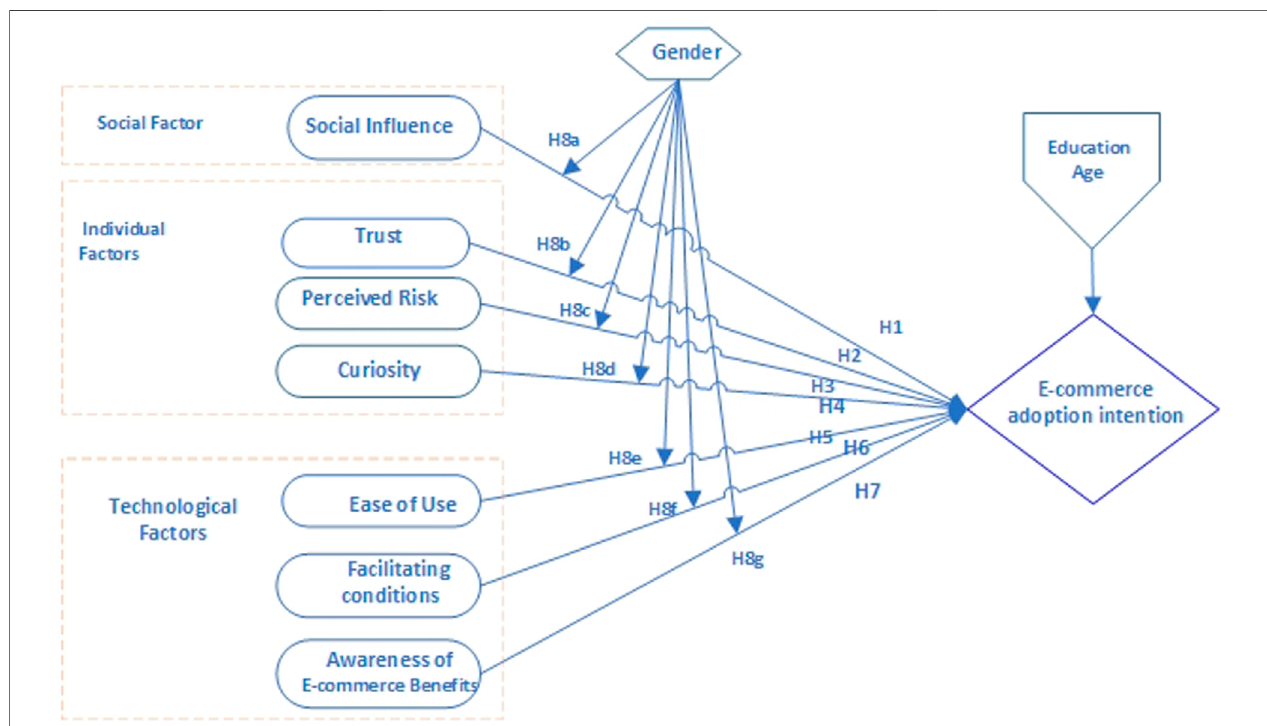
FIGURE 1 | Conceptual